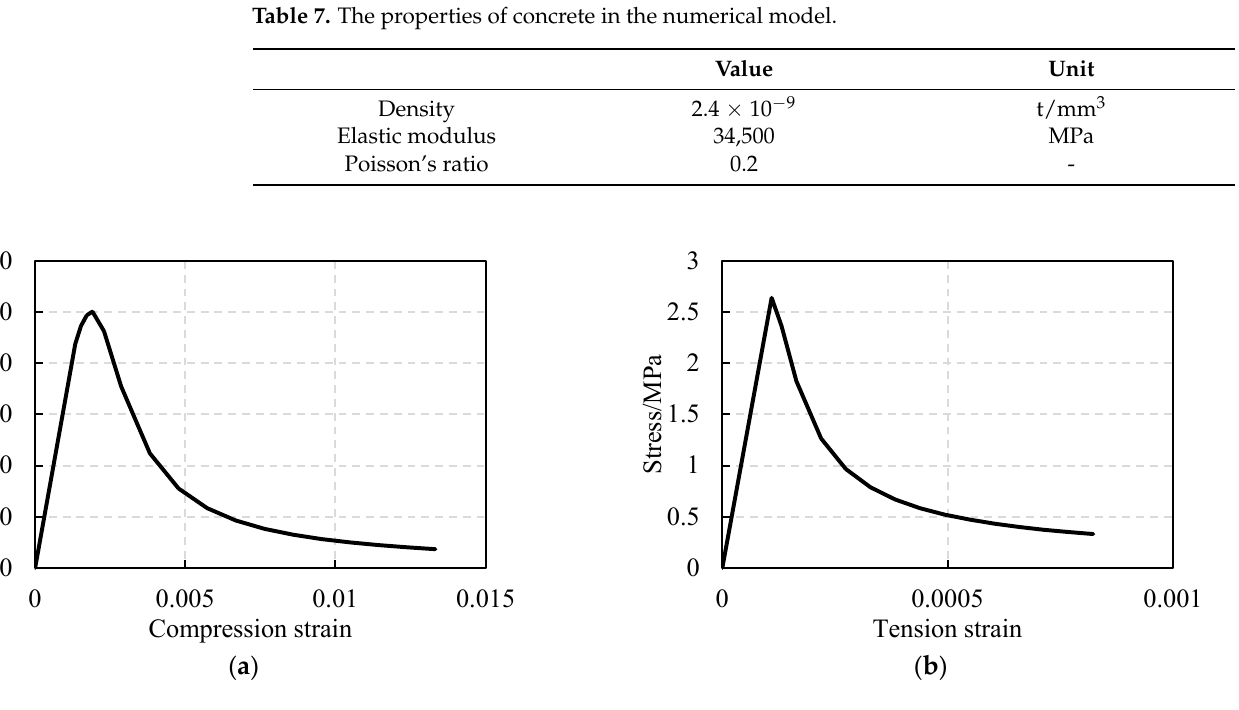
Figure 7. ( a ) Constitutive model of elastoplastic damage for concrete under compression. ( b ) Constitutive model of elastoplastic damage for concrete under tension.